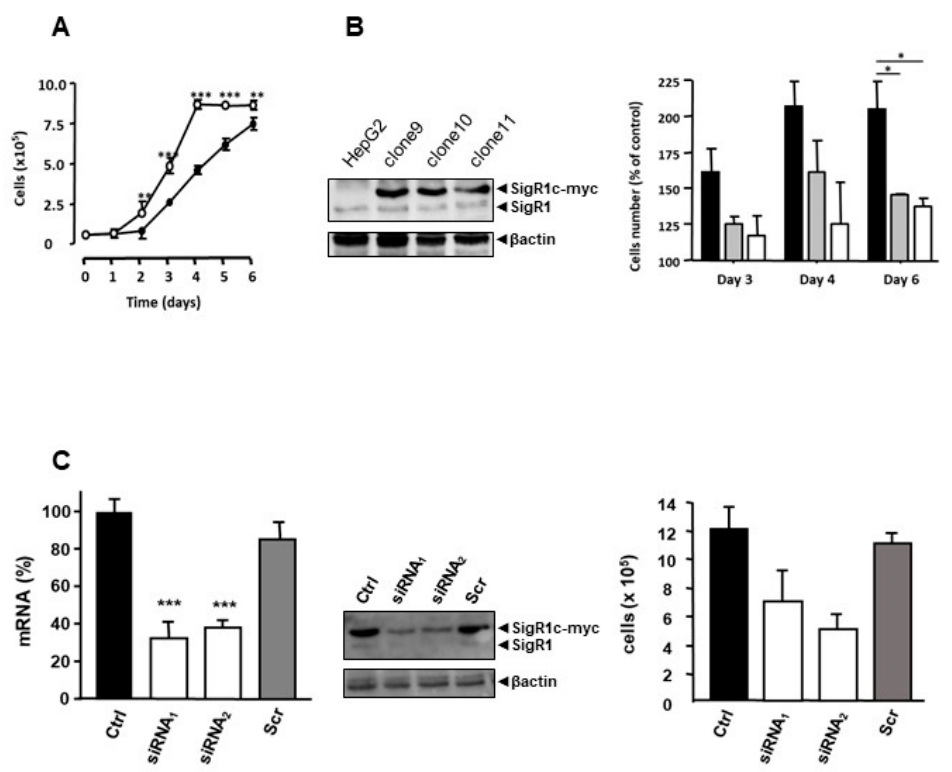
Figure 6. Overexpression of SigR1 increases the proliferation rate of HepG2 cells. ( A ) The proliferation rate of wild type HepG2 cells (black dots) and HepG2 cells that stably overexpress SigR1 (white dots). Results are expressed as means ± SEM ( n = 6). ( B ) HepG2 cells were transfected with SigR1c-myc to make stable clones (Clone 9, Clone 10, and Clone 11) with differential expression of SigR1. The right panel shows the rate of proliferation of these clones in % of wild type HepG2 cells. Results are expressed as means ± SEM ( n = 5). ( C ) mRNA expression of SigR1 by qPCR (left panel) and protein expression of SigR1 and SigR1c-myc by western blot (middle) on Clone 9 transfected or not with two different siRNA directed against SigR1 or with a siRNA scramble (Scr). The right panel shows the rate of proliferation of Clone 9 in these conditions. Data are shown as mean ± SEM ( n = 5), Mann–Whitney U test. * p < 0.05; ** p < 0.01; *** p < 0.001. More details of western blots, please view at the